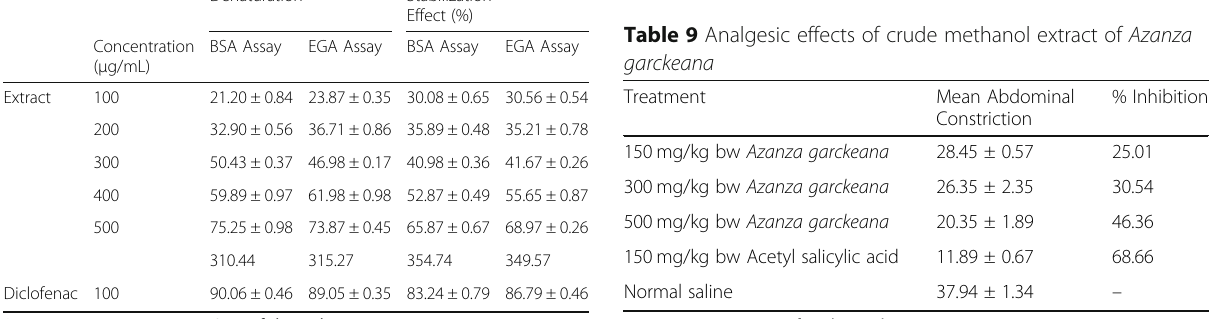
Table 7 Effect of ethyl-acetate pulp extract of Azanza garckeana on heat induced protein denaturation Inhibition of Protein Denaturation